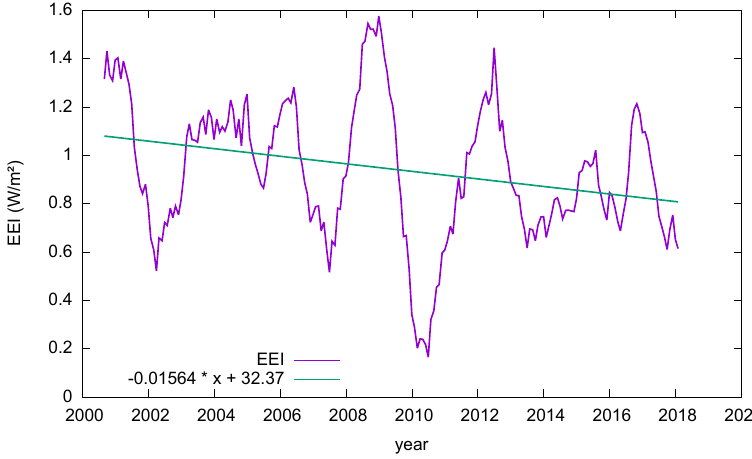
Figure 14. 2000–2018 variation of Earth Energy Imbalance.